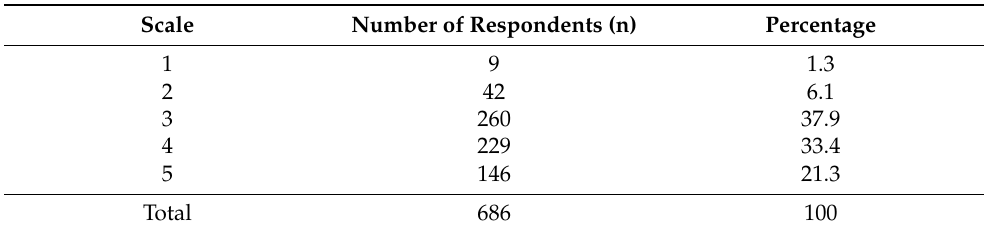
Table 3. Overall pet wellbeing during lockdown using a Likert-like scale from 1 “Wellbeing is far worse” through to 5 “Wellbeing is much